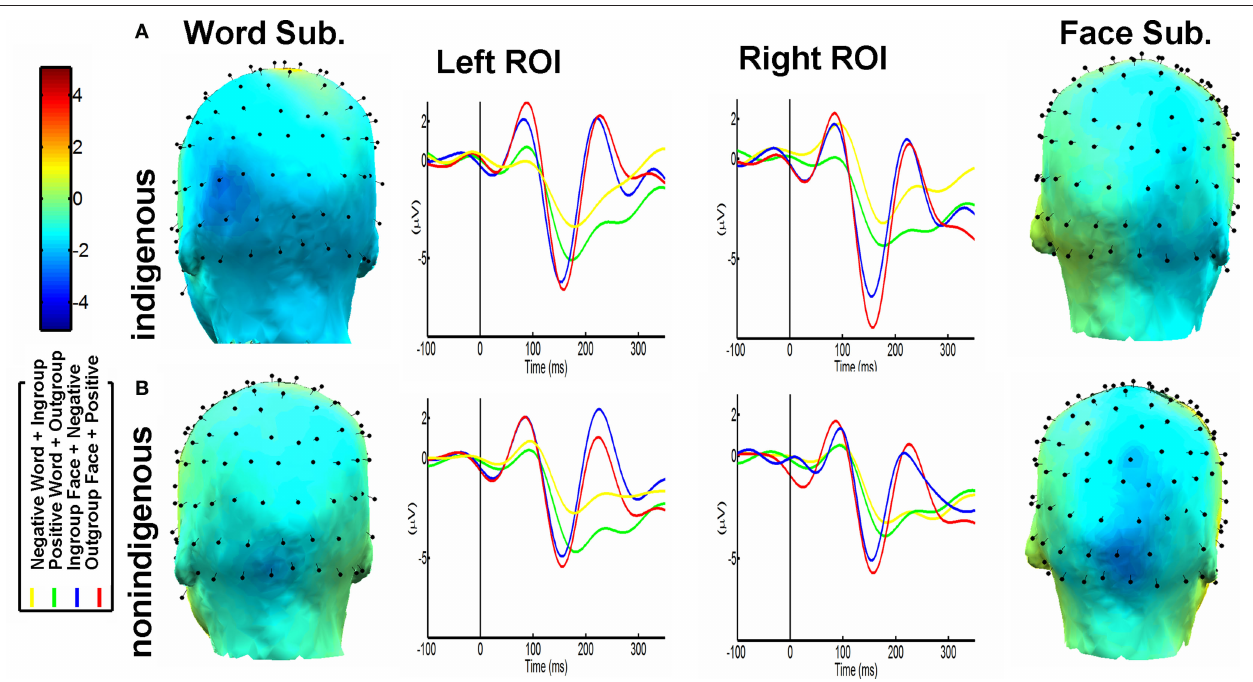
Figure 2 | N170 waveform and topography. (A) Indigenous Participants. N170 Modulation based on ingroup-negative association and outgroup- positive association, predominant in the left hemisphere for words, and in the right for faces. Word and Face Topo Maps subtractions